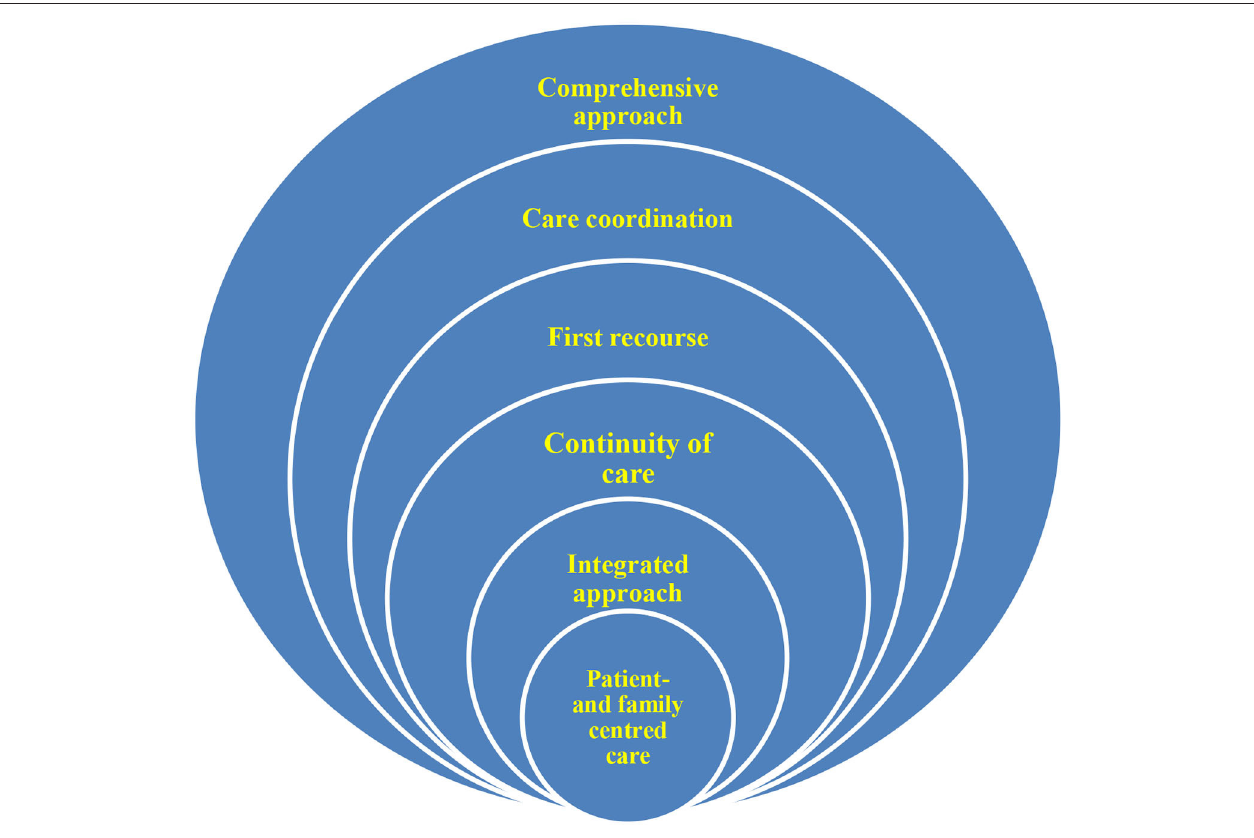
FIGURE 1 | The six Ukrainian CVs. TABLE 2 | Characteristics of online survey participants.